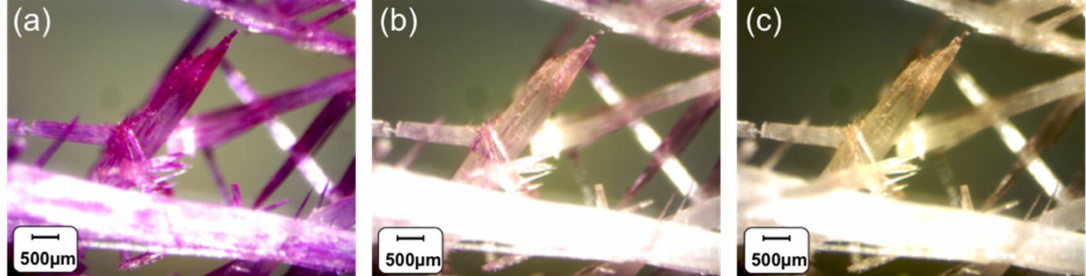
Figure 1. Crystals of the norbornene-spiropyran derivative (SP) exhibiting solid-state photoisomerisation under the following conditions: ( a ) 1 min UV irradiation, ( b ) additional 1 min white light irradiation, and ( c ) additional 2 min white light irradiation. The strong purple colour in ( a ) is indicative of significant formation of the merocyanine isomer, whereas the lighter purple colour in ( b ) indicates co-existence of both isomers. The colourless crystals ( c ) indicate that the system has largely reverted to the spiropyran